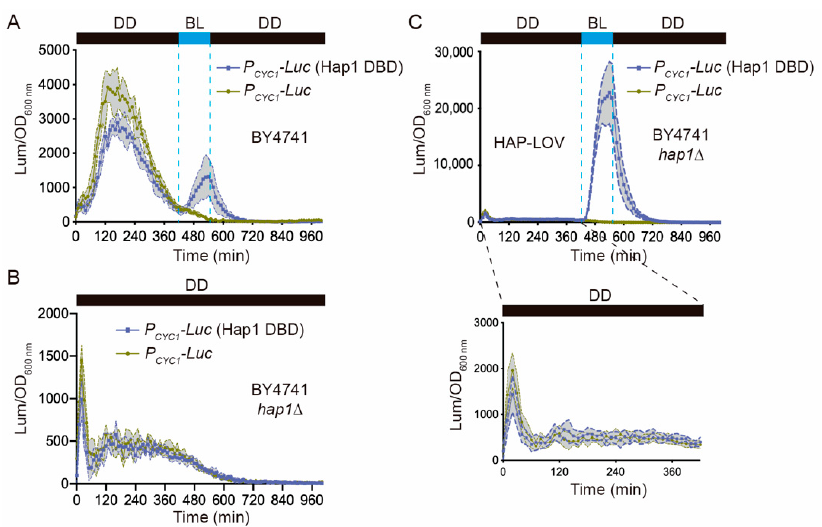
Figure 2. The HAP-LOV switch responds to light and its activity is higher in the absence of the endogenous Hap1p. Luciferase activity in response to HAP-LOV in the BY4741 or BY4741 hap1 ∆ strains harboring the CYC1 ( P CYC1 ) promoter controlling luciferase ( Luc ) expression: ( A ) changes in reporter levels upon a blue-light (BL) pulse of 120 min (dashed lines) in the BY4741 strain; ( B ) background luciferase expression under constant darkness condition (DD) in the BY4741 hap1 ∆ strain; ( C ) BL pulse of 120 min (dashed lines) in the BY4741 hap1 ∆ strain. The background luciferase expression prior to the BL pulse has been magnified. In all panels, the yeast strain carrying only the CYC1 ( P CYC1 ) promoter controlling luciferase ( Luc ) expression, but not carrying HAP-LOV, is shown as a control. The graphs show the average of normalized luciferase expression in six biological replicates, with the standard deviation represented as a shaded region.